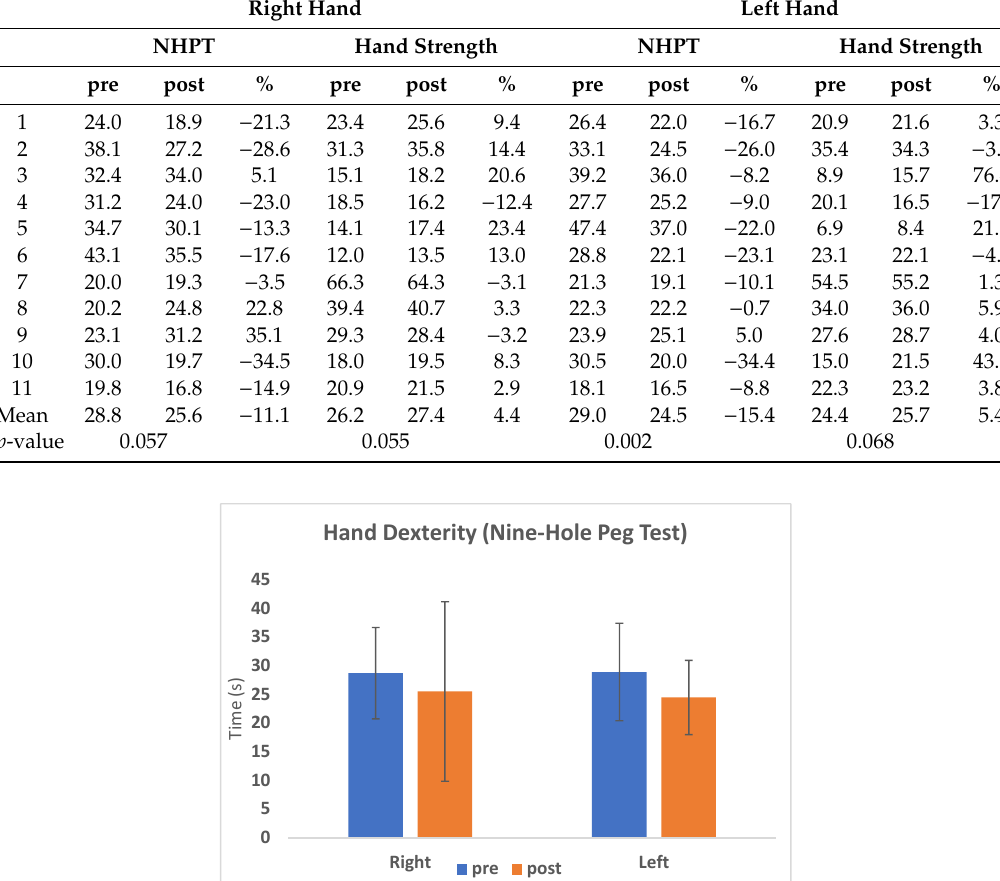
Table 4. Measurement of dexterity and hand strength. The percentage of improvements for NHPT and hand strength was reported in green.